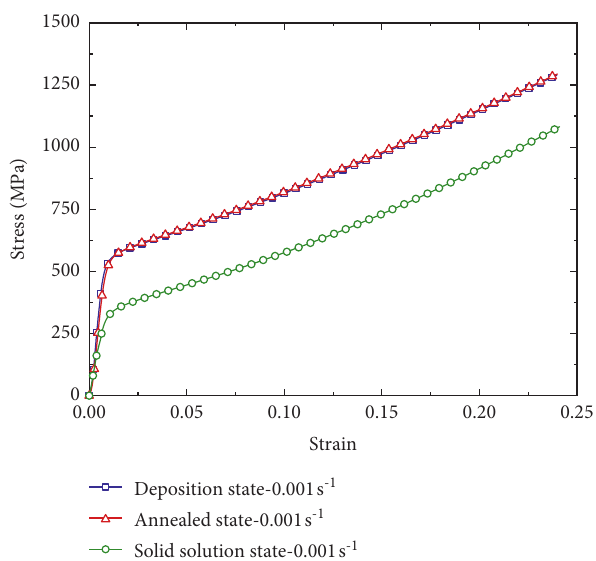
Figure 9: Quasistatic compressive stress-strain